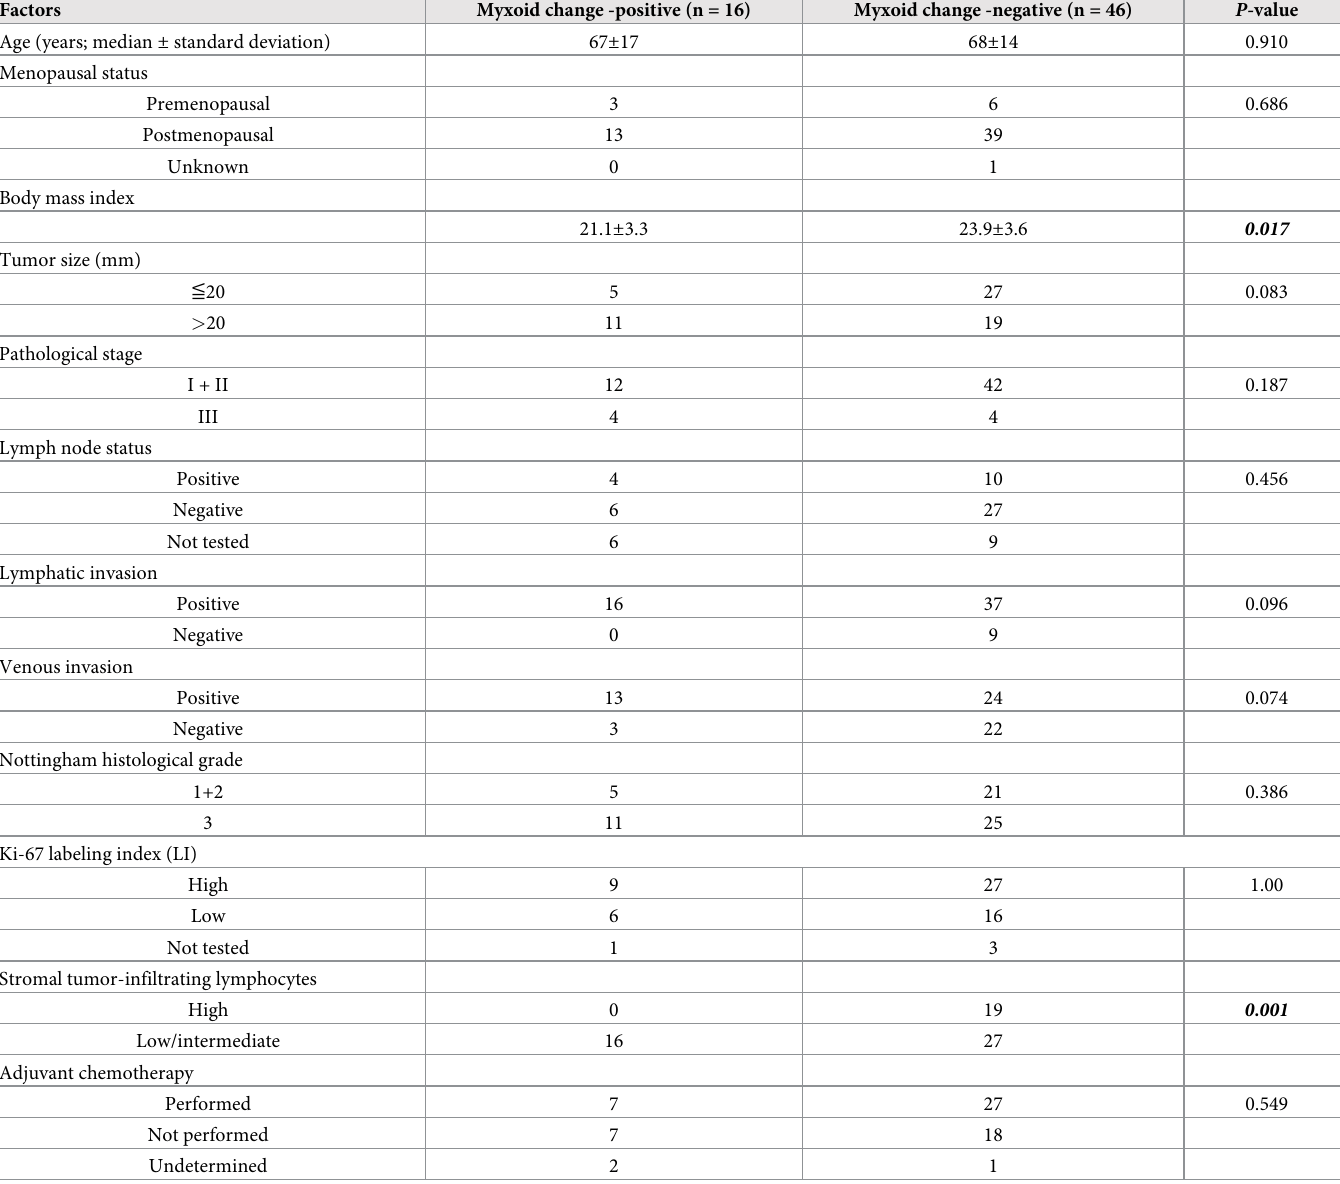
Table 2. Association of myxoid change with clinicopathological